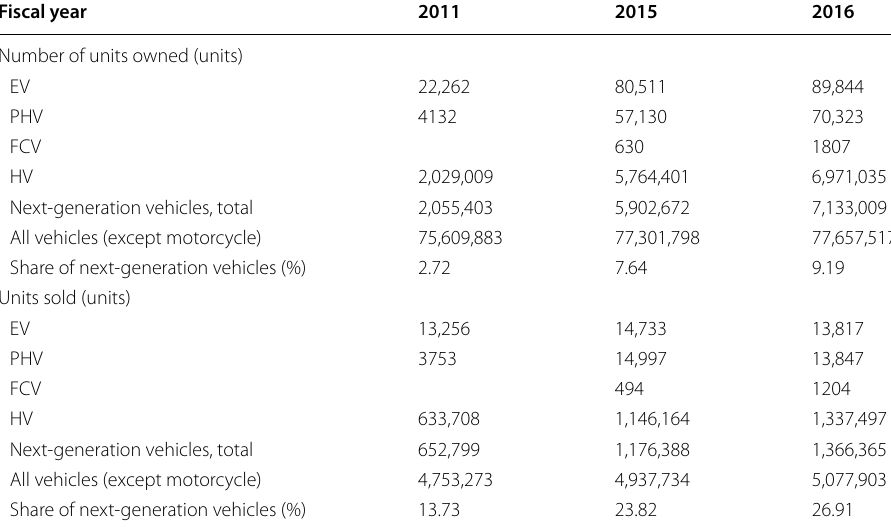
Table 2 Number of next-generation vehicles and number of units sold. Source : Japan Next Generation Automobile Promotion Center (2018), Japan Automobile